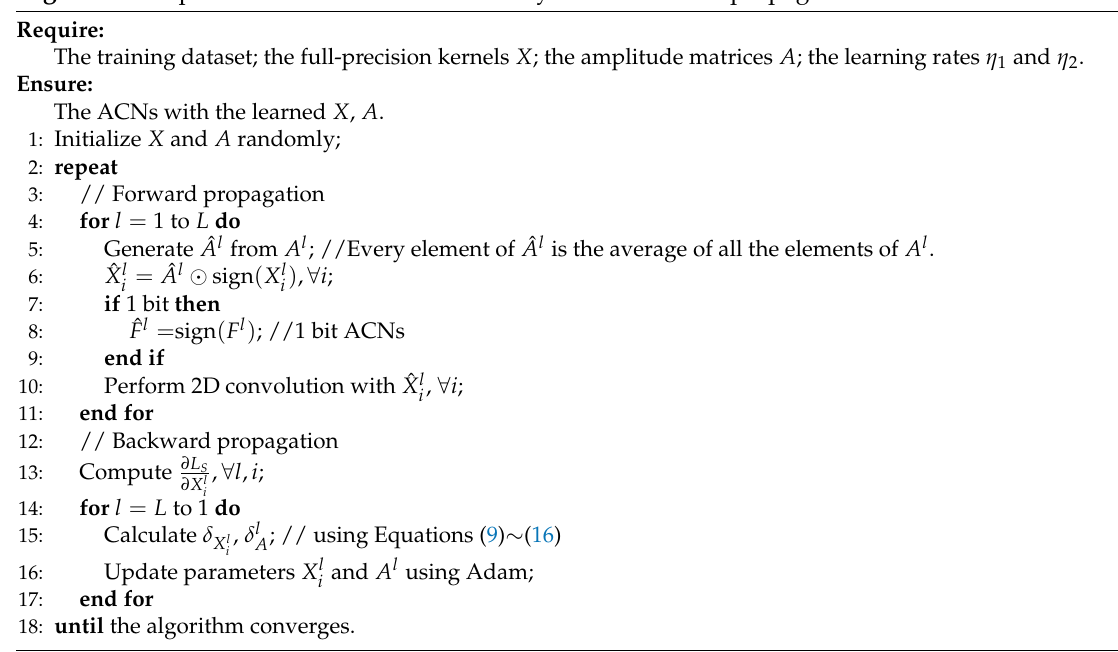
Algorithm 1 Optimization of ACNs with the asynchronous back